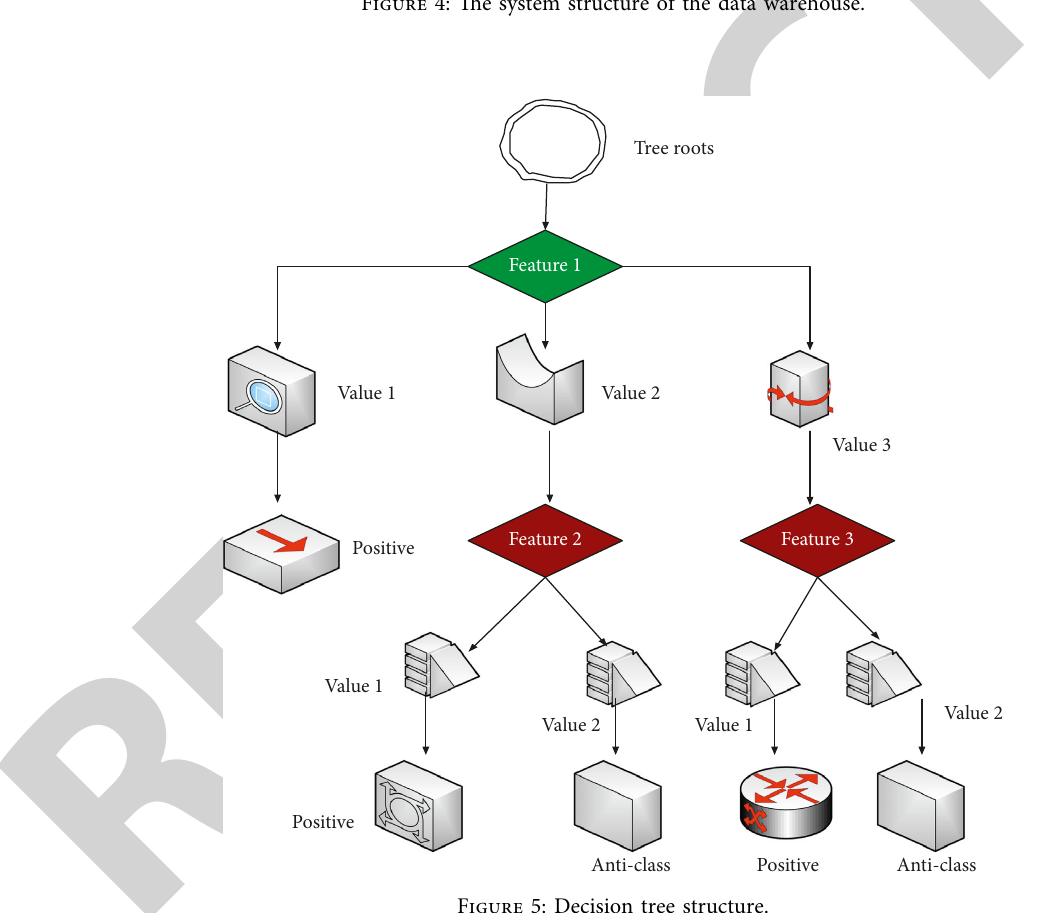
Figure 4: The system structure of the data